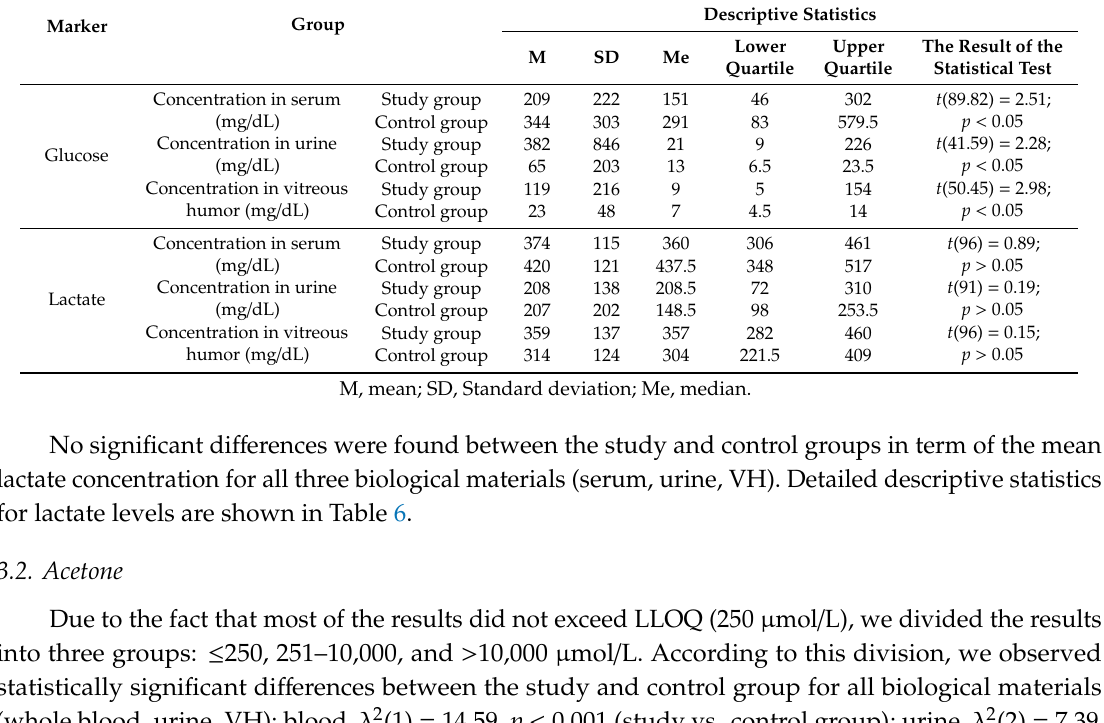
Table 6. Descriptive statistics for glucose and lactate determinations in the study and control